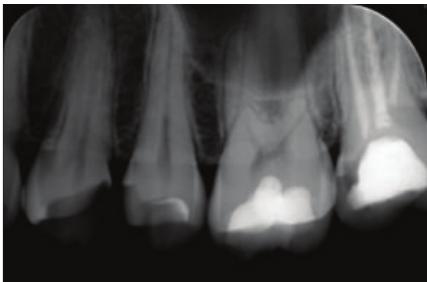
Figure 1: Initial radiography showing proximal cavity on tooth number 27.